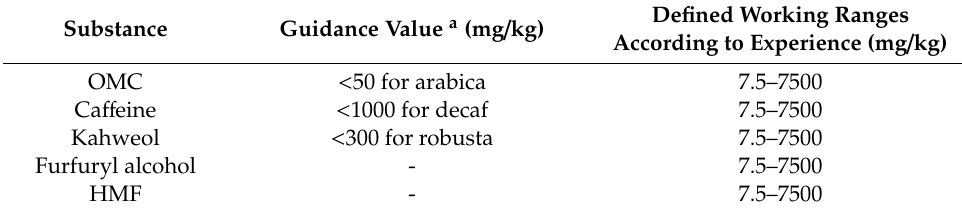
Table 1. Working standards